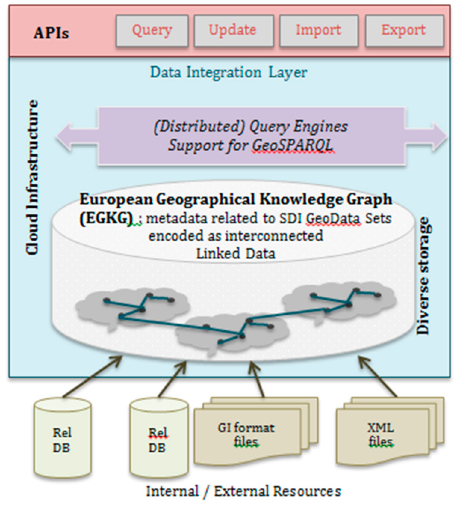
Figure 6. Implementation of the European Geographic Knowledge Graph (EGKG) on the cloud, reusing the general cloud-based infrastructure overview from [43].